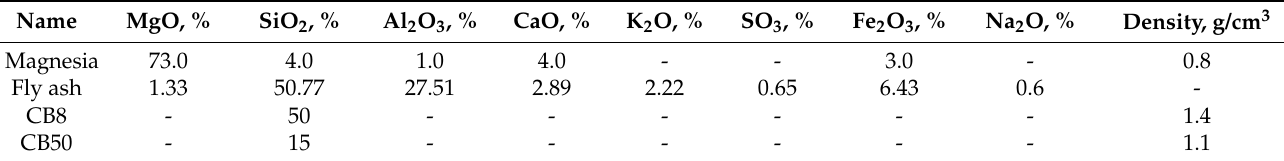
Table 1. Composition of the used raw materials.